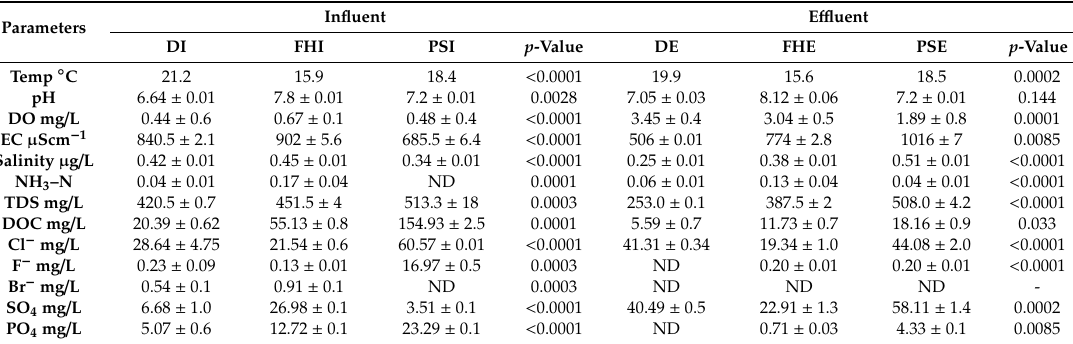
Table 1. Physicochemical properties of influent and effluent water samples observed from three wastewater treatment plants (WWTPs). (Mean ± SD, n = 3).